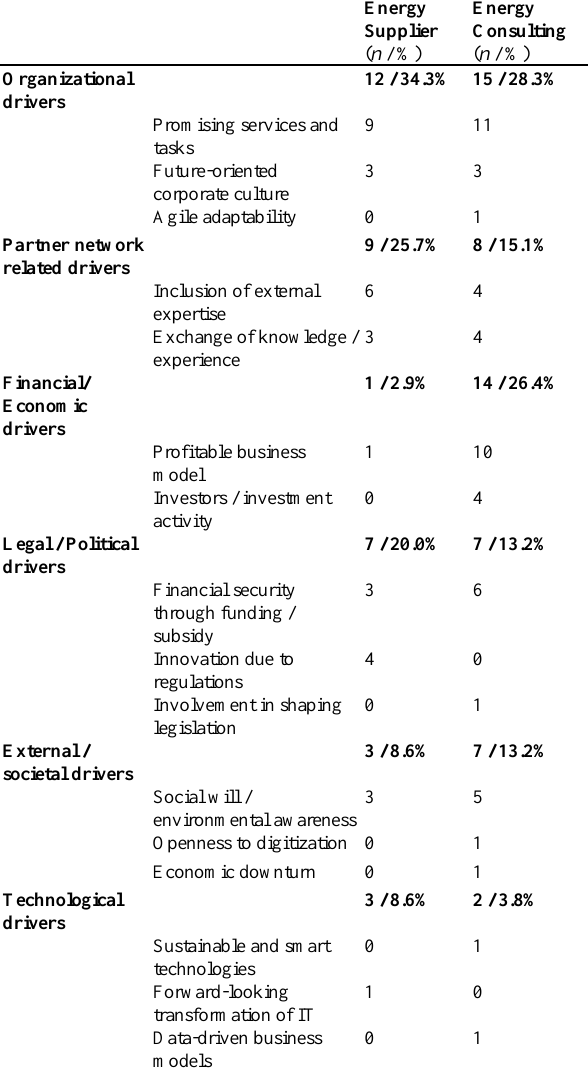
Table 2 . Main drivers with their subcategories ( n = the number of mentions of the specific drivers category by experts of the respective group, % = percentage share of the upper category in the total number of named drivers by the respective